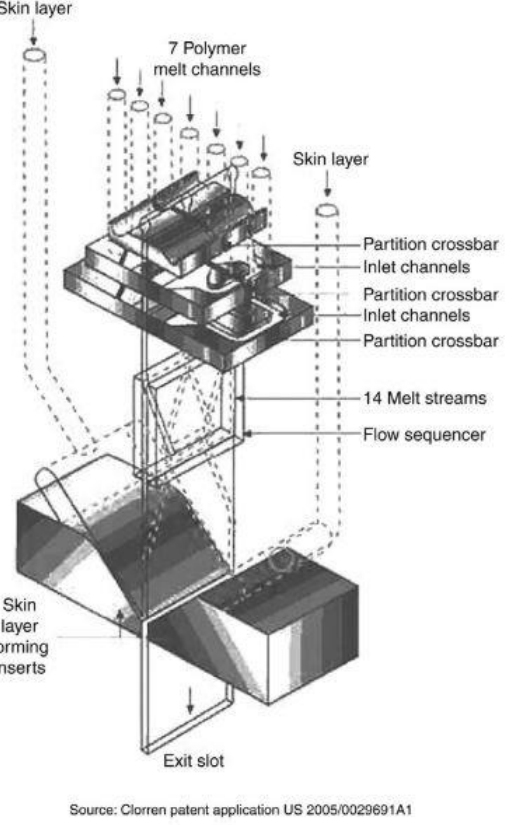
Figure 10. Multi-nano-layers feedblock design by Cloeren Incorporated. Adapted from [84]. Before the fabrication of single shot feedblocks, Dow Chemical Company developed a combination processing technique using a simple two to five layered feedblock with a series of sequential layer multiplication dies. In this approach of sequential layer